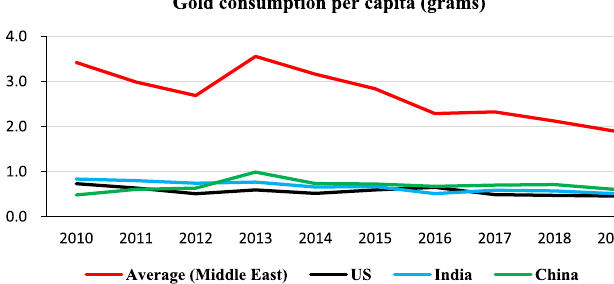
Fig. 7 FDI and Social Unrest in MENA region